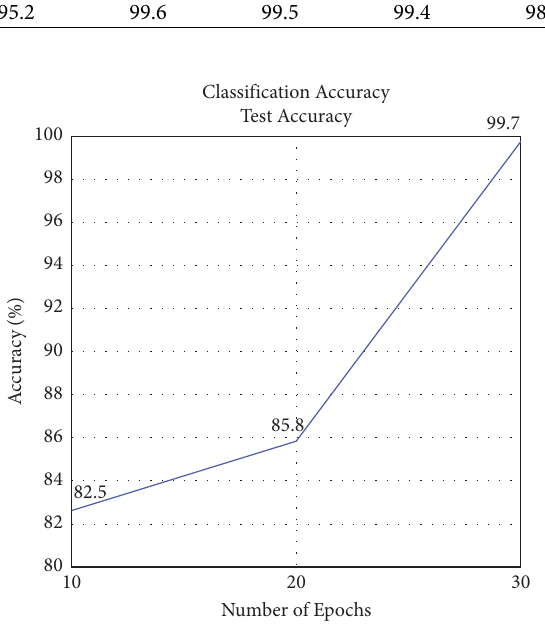
Figure 6: Classifcation accuracy of VGG-16 using Adam